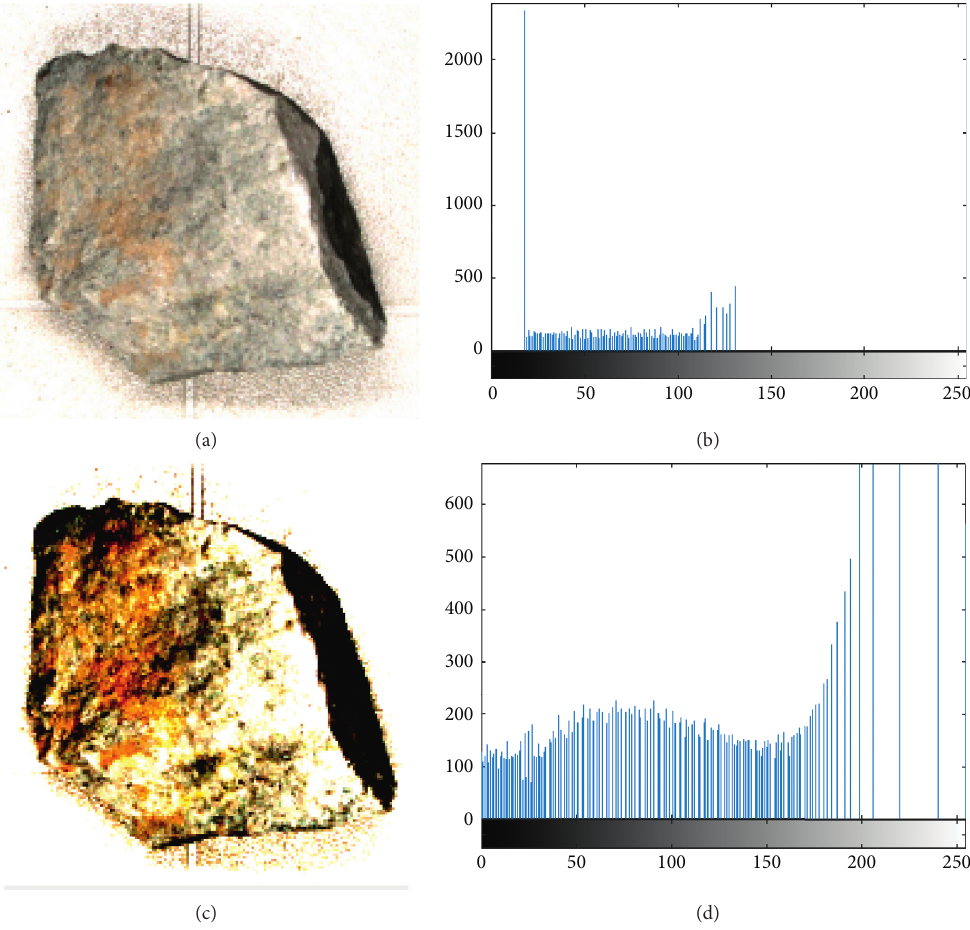
Figure 7: Sample anorthosite treatment. (a) Image before processing. (b) Histogram of gray distribution before processing. (c) Image after processing. (d) Histogram of gray distribution after processing.